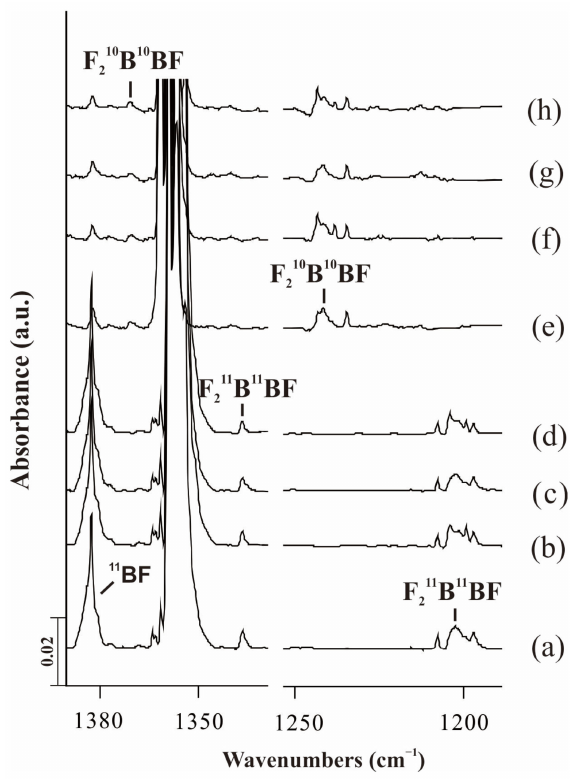
Figure 1. Infrared spectra of the laser-ablated B atoms’ reactions with BF 3 in excess solid neon. ( a ) co-deposition of 11 B + 1.0% 11 BF 3 for 60 min; ( b ) after annealing to 8 K; ( c ) after λ > 300 nm irradiation for 6 min; ( d ) after annealing to 12 K; ( e ) co-deposition of 10 B + 0.5% 10 BF 3 for 60 min; ( f ) after annealing to 8 K; ( g ) after λ > 300 nm irradiation for 6 min; ( h ) after annealing to 12